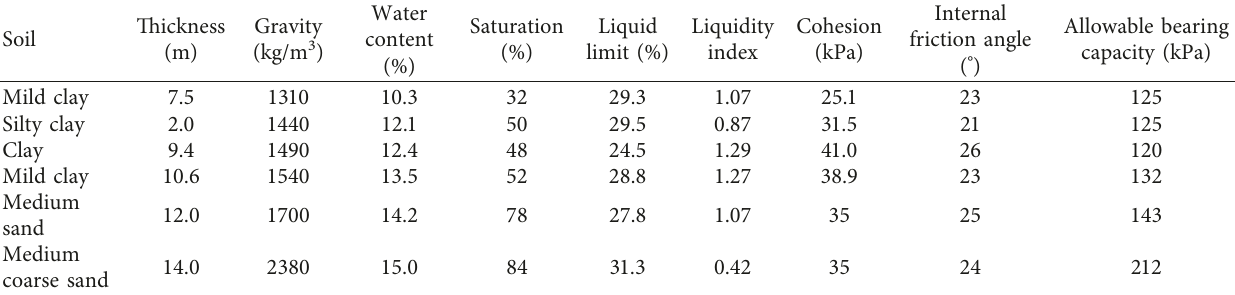
Table 1: Geological